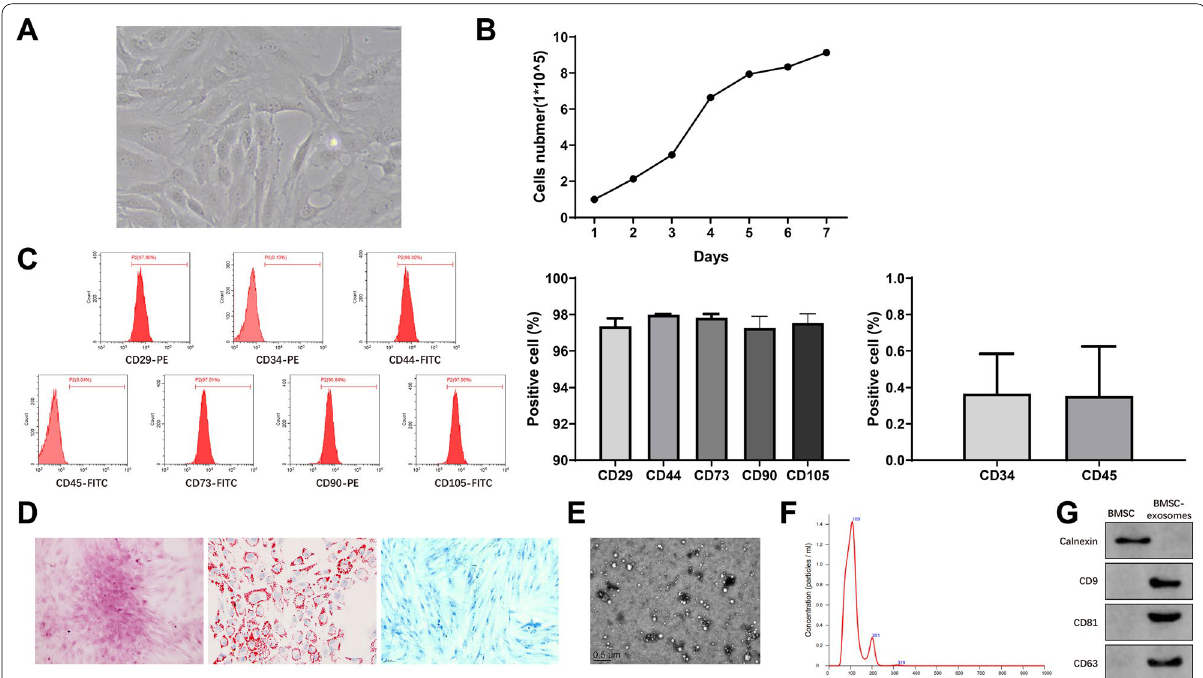
Fig. 1 Identification of BMSCs and BMSC-exosomes. A Morphology of the third-generation BMSCs; B Growth curve of the third-generation BMSCs; C Flow cytometry measured the expression of surface markers (CD90, CD73, CD29, CD105, CD44, CD34, and CD45) in BMSCs; D Alizarin Red staining assessed the osteogenic differentiation of BMSCs, Oil red O evaluated the adipogenic differentiation of BMSCs, and Alcian blue staining revealed the chondrogenic differentiation of BMSCs; E The morphology of the exosomes extracted from BMSCs was observed by transmission electron microscope; F Nanoparticle tracking analysis of BMSC-exosomes; G Western blotting measured the expression of CD81, CD63, CD9, and Calnexin in BMSC-exosomes. BMSC, bone marrow mesenchymal stem